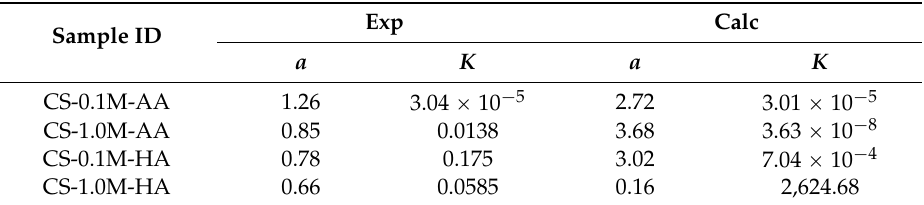
Table 5. Experimental MHS coefficients according to Kasaai [56] and MHS coefficients calculated upon numerical simulations. Refer to Table 1 for sample